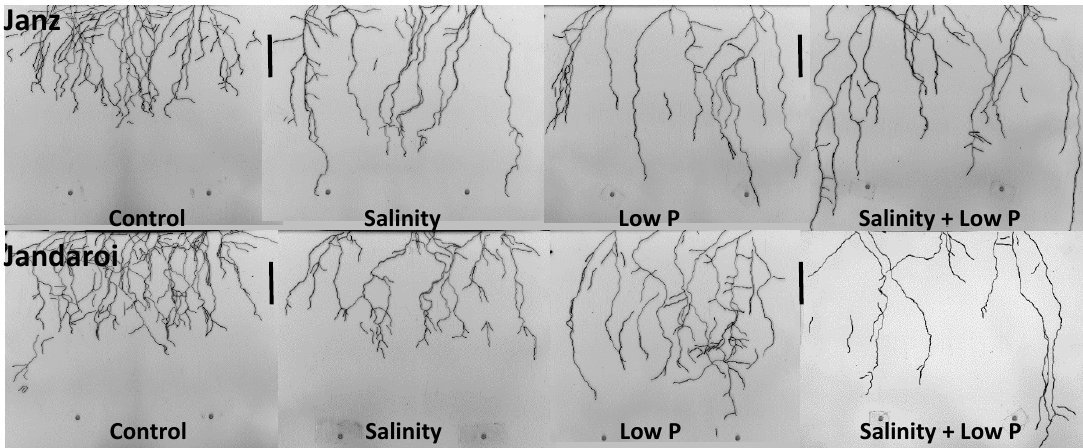
Figure 4. Scanned root images from the drawing at the end of the experiment (40 DAS) showing variations in root length and depth between the salt-tolerant (Janz) and salt-sensitive (Jandaroi) wheat cultivars in response to salinity, low P supply and their interaction. Bar = 5 cm.